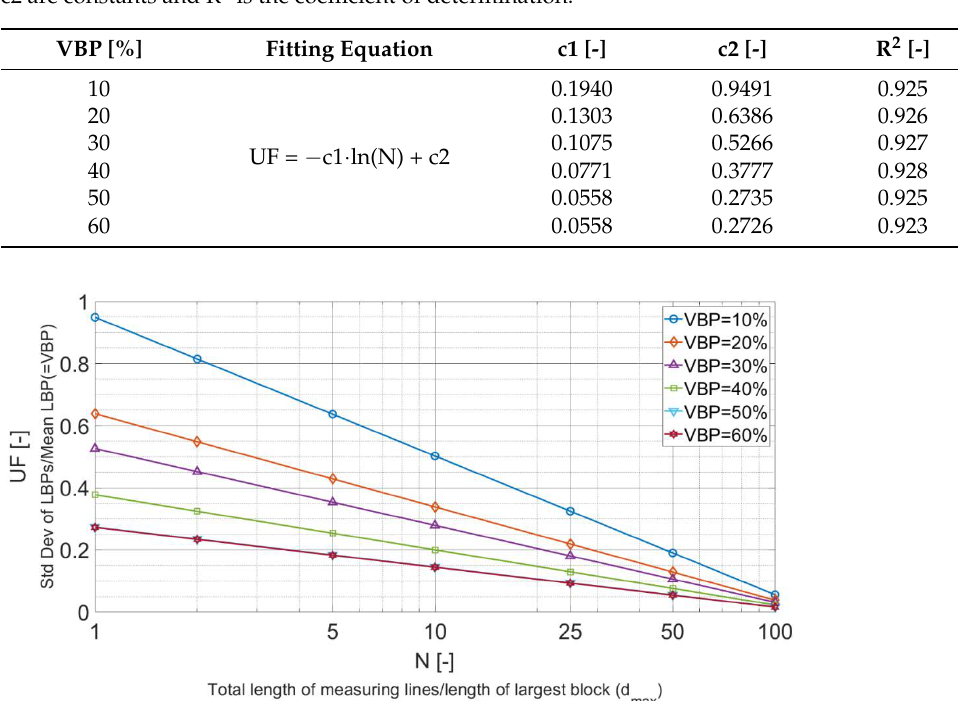
Table 1. Specifications of the linear fittings shown in Figure 10. UF is the uncertainty factor, c1 and c2 are constants and R 2 is the coefficient of determination.